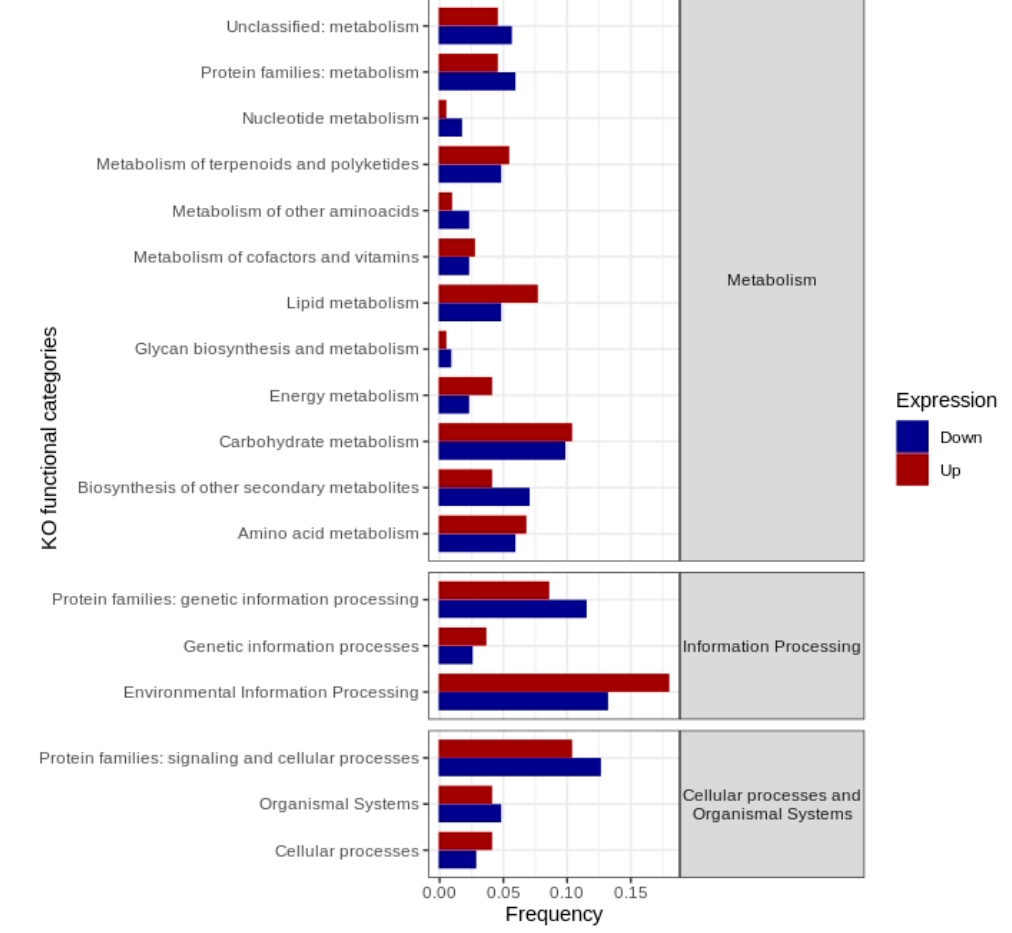
Figure 3. KEGG orthology-based functional annotation of differentially expressed genes in Musa acuminata var. Calcutta 4, 3 days after inoculation with Pseudocercospora musae . Differential expression was based on log2FC of transcripts from inoculated plant tissues versus non-inoculated controls.